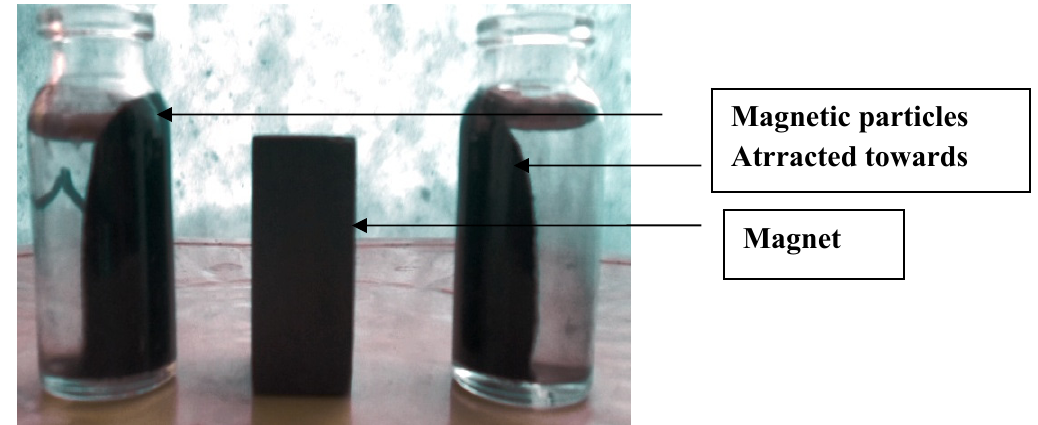
Fig.7. Photo image showing of magnetic nano adsorbent contains sufficient magnetic